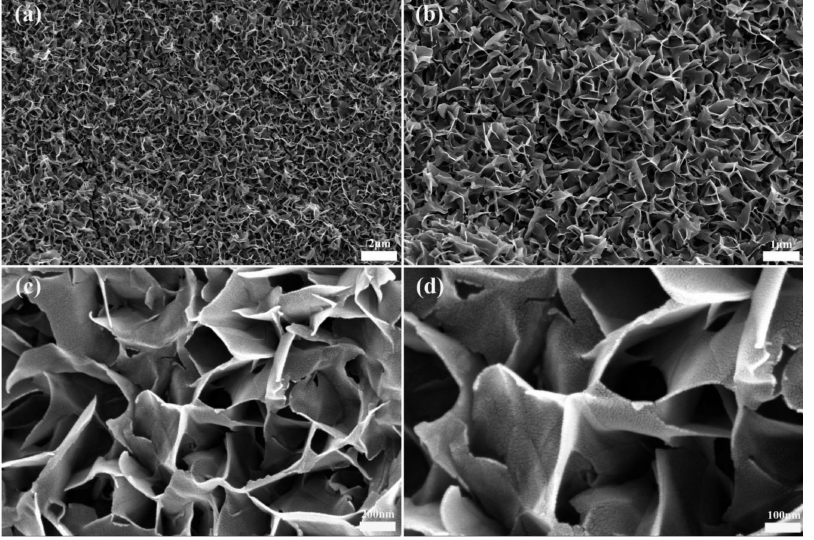
Figure 4. SEM images of ZCMG. ( a ) 5 K magnification, ( b ) 10 K magnification, ( c ) 50 K magnification and ( d ) 100 K